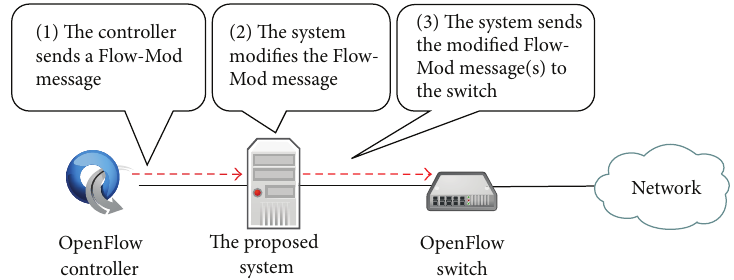
Figure 8: The behavior of capture module in the case of Flow-Mod message reception from the OpenFlow controller.